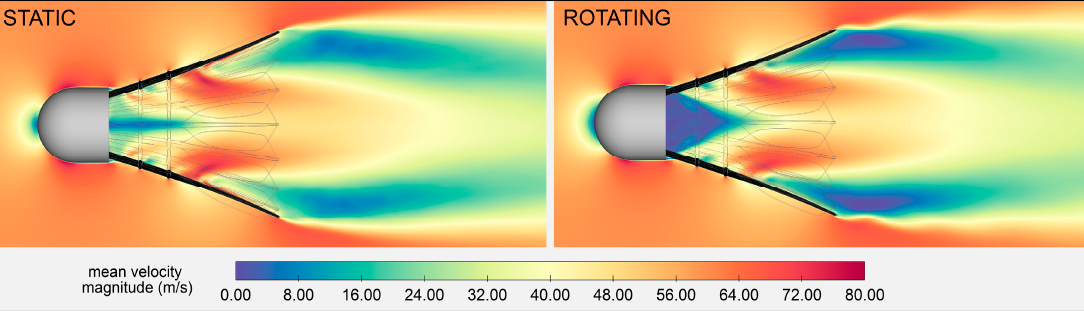
Figure 4. Visualization of centre plane mean velocity flow field, Re = 2.7 × 10 5